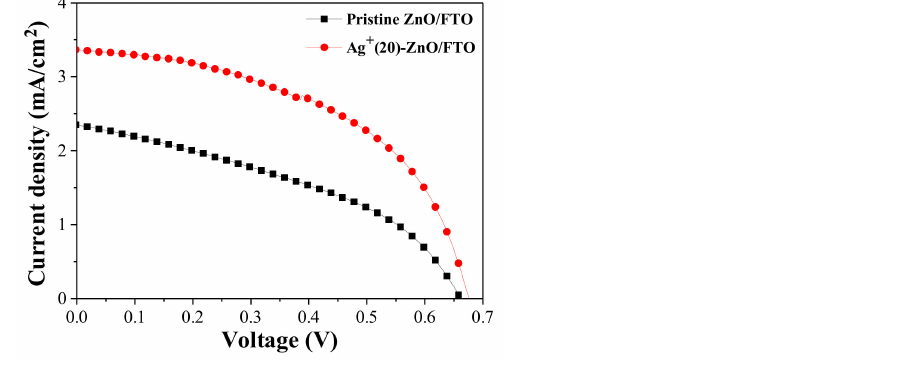
Figure 5. J–V characteristics of the DSCs with the pristine ZnO/FTO and Ag + (20)–ZnO/FTO photo- electrodes, measured under AM 1.5